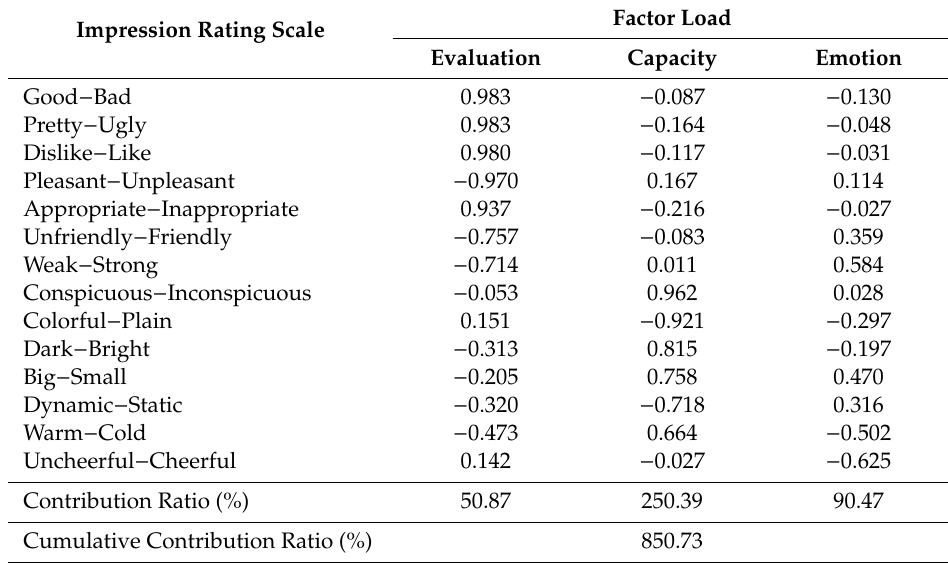
Table 8. Factor loads when treating both Japanese persons and foreigners as being part of the same population.